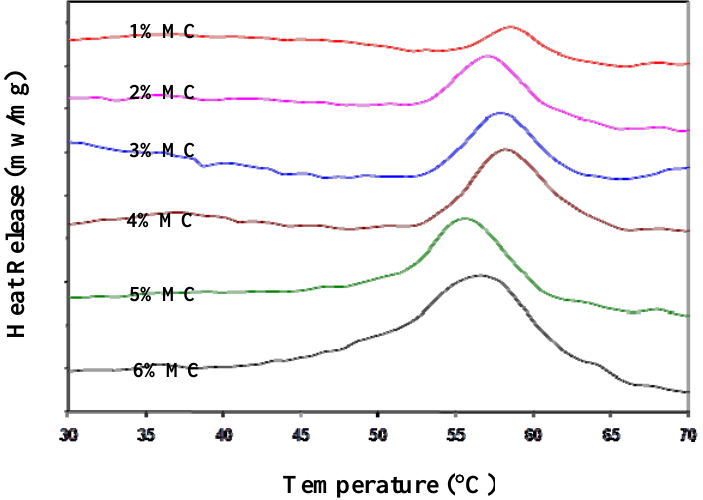
Figure 2. A series of differential scanning calorimeter (DSC) thermograms showing the incipient gelation temperature of MC M0512 (Mol. wt of 88,000) at various concentrations (1, 2, 3, 4, 5, and 6%) in 1× PBS solution. The thermograms from top to bottom represent increasing concentrations of MC in solution. For the ease of visualization, the thermograms for all the concentrations were displaced by a stepwise amount to prevent overlapping of the curves. As shown in Figure 2, increasing the amount of MC in solution not only increases the endothermic peak height but it also makes it broader. This suggests that the total energy absorbed during heating of the MC-solutions is dependent upon the concentration of MC. The temperature is shown on the x-axis while the endothermic heat release is shown on the y-axis. Note that the scale bar on the y-axis is not absolute and the curves have been physically separated to clarify the distinction between the various samples. Hence, no scale bar values are shown on the